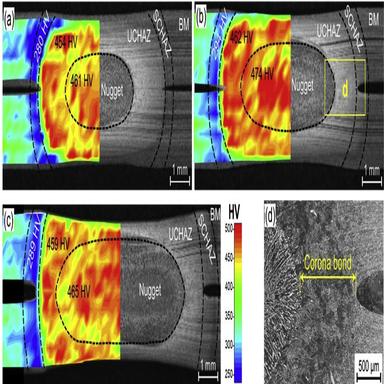
Etched macro profiles of the RSW joint and Vickers hardness distribution. (a) 5.0 kA joint; (b) 6.5 kA joint; (c) 8.5 kA joint; (d) enlarged view of location d in (b) showing the corona bond. Note that the values given in (a)-(c) are the average hardness values in the weld zones.